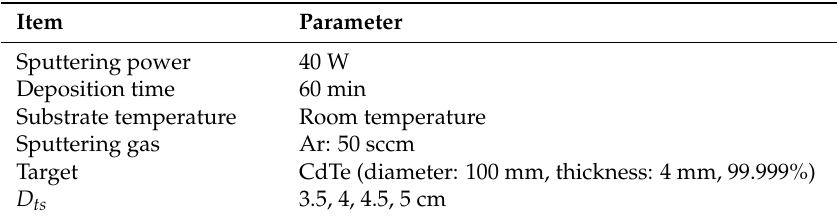
Table 1. Deposition parameters of CdTe films prepared by magnetron sputtering.